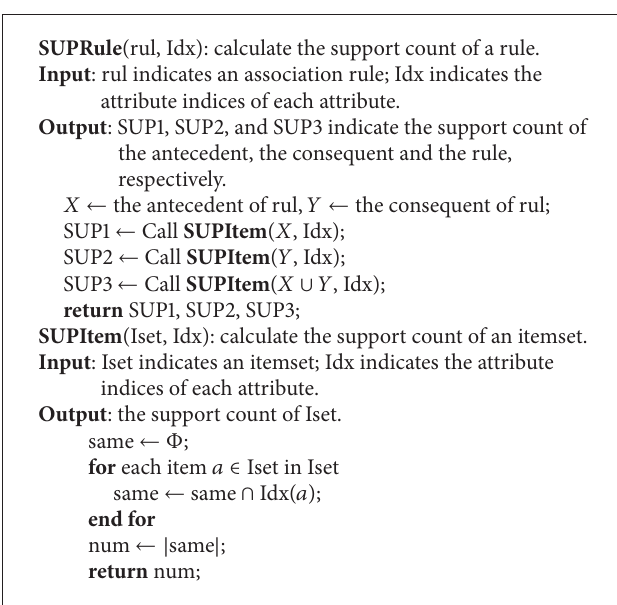
Pseudocode 2: Pseudocode of calculating the support